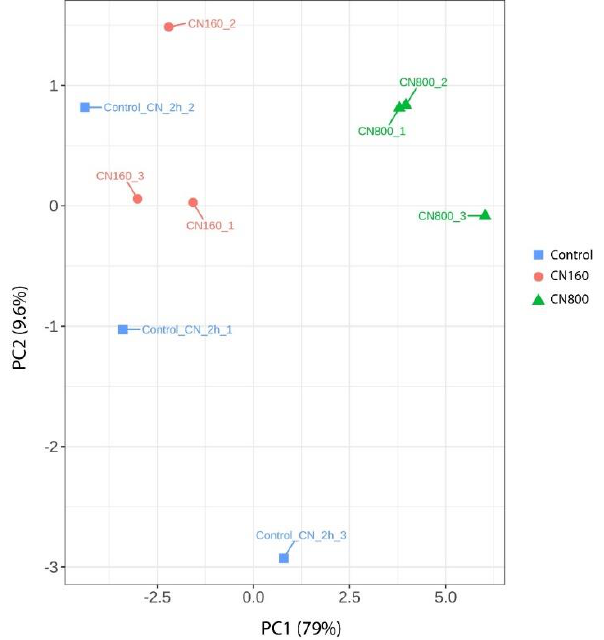
Figure 5. Principal Component Analysis plot of the transcriptomic response of S. cerevisiae to two different concentrations (160 and 800 mg L −1 ) of NTX1 MWCNTs and of non-exposed cells (Control). Percentage of the total variance explained by each principal component is indicated on the axis.